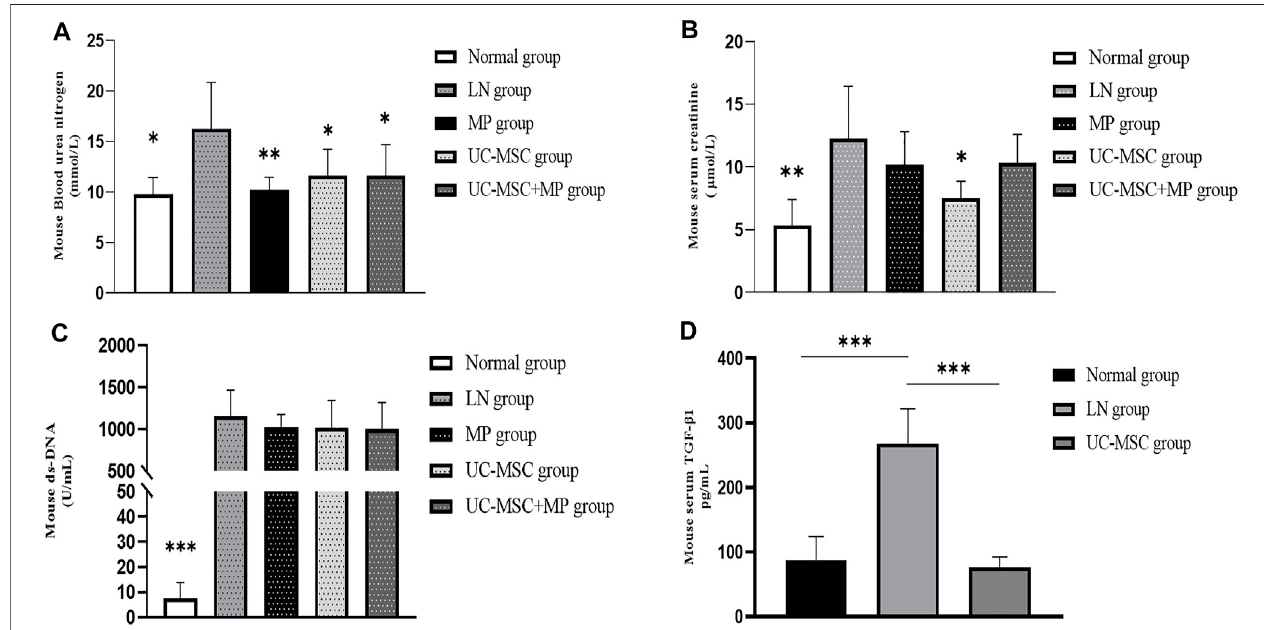
FIGURE2| Changesofrenalfunction,serumds-DNA,andserumTGF- β 1level.Comparisonofbiochemicalmeasurement. (A) Bloodserumcreatininelevel(mmol/ L); (B) blood urea nitrogen level ( μ mol/L); (C) serum ds-DNA level (U/mL); (D) serum TGF- β 1 level (pg/ml) vs. LN group: * p < 0.05; ** p < 0.01; *** p < 0.001.